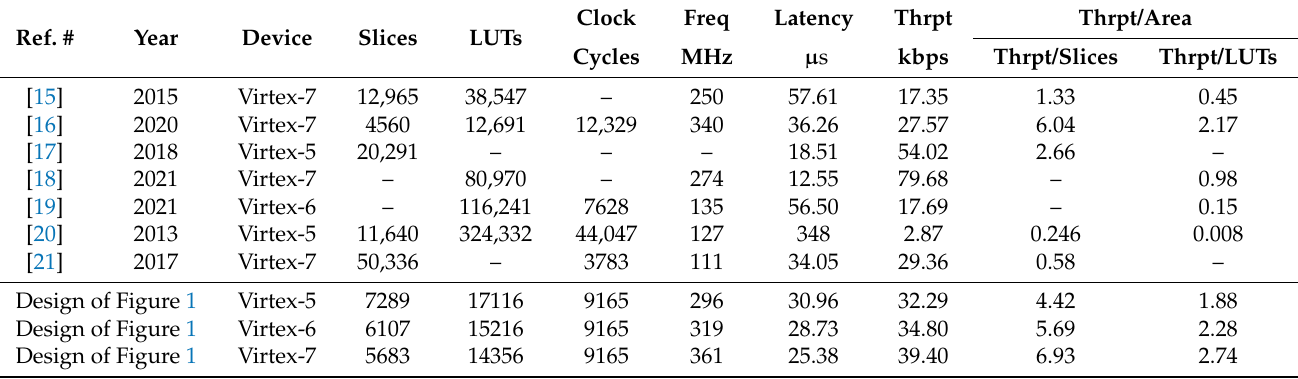
Table 3. Comparison to most relevant state-of-the-art PM architectures over GF ( 2 571 )